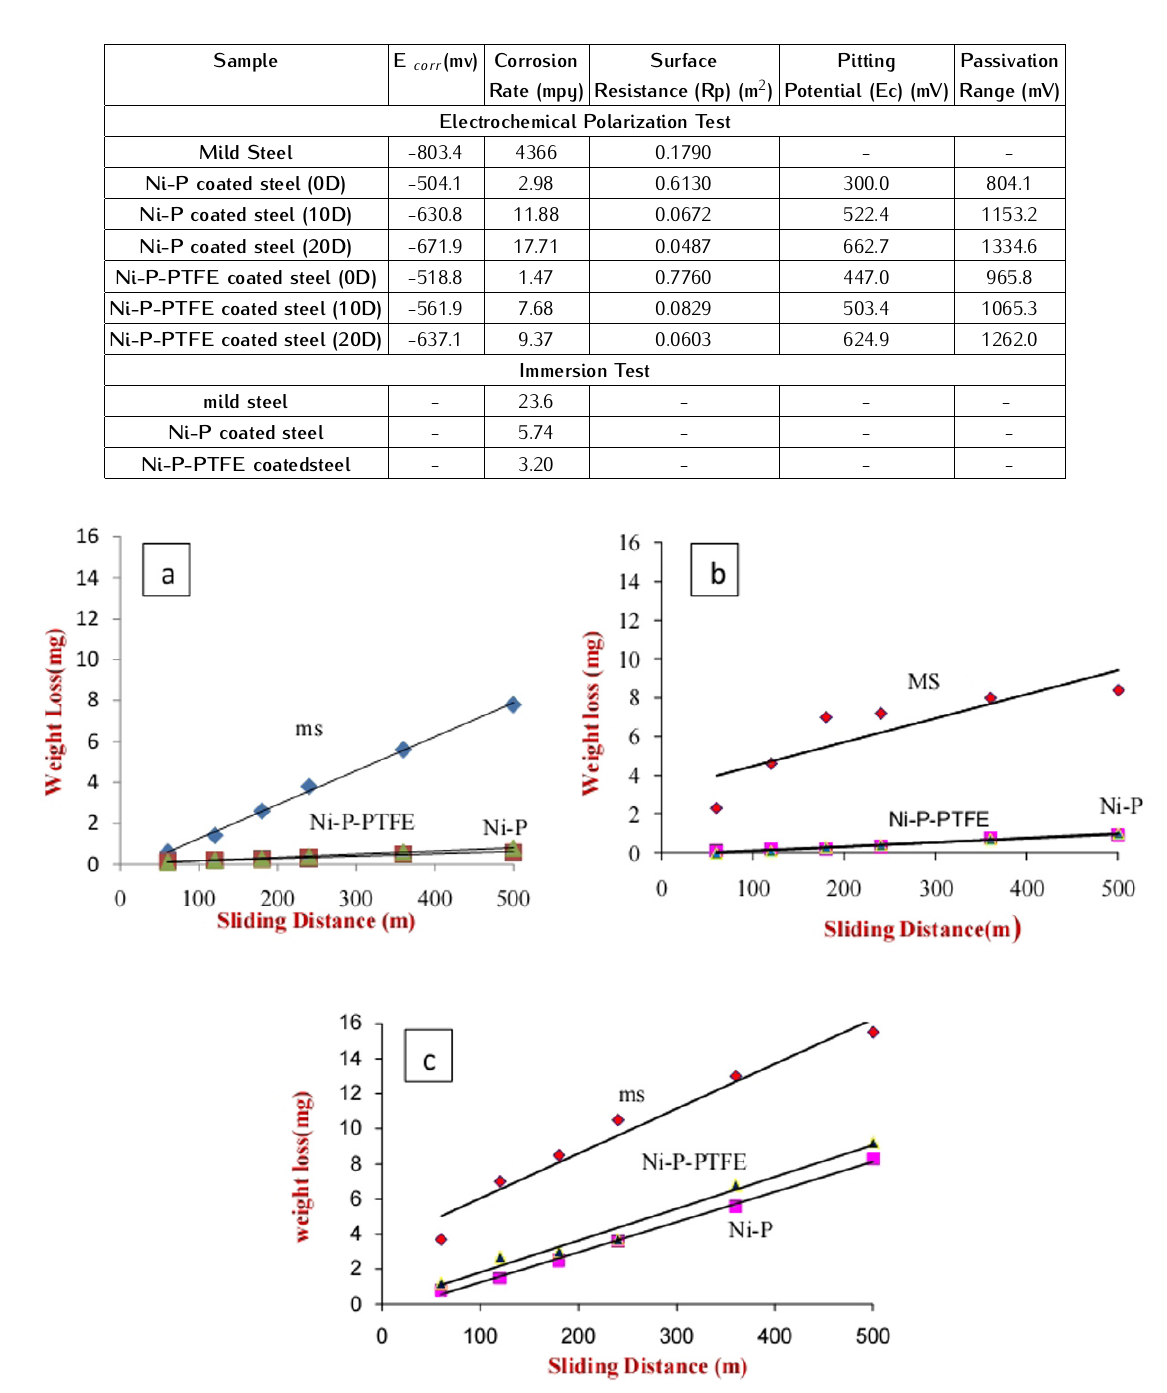
Table 2. Corrosion Parameters of Uncoated and Coated Mild Steel